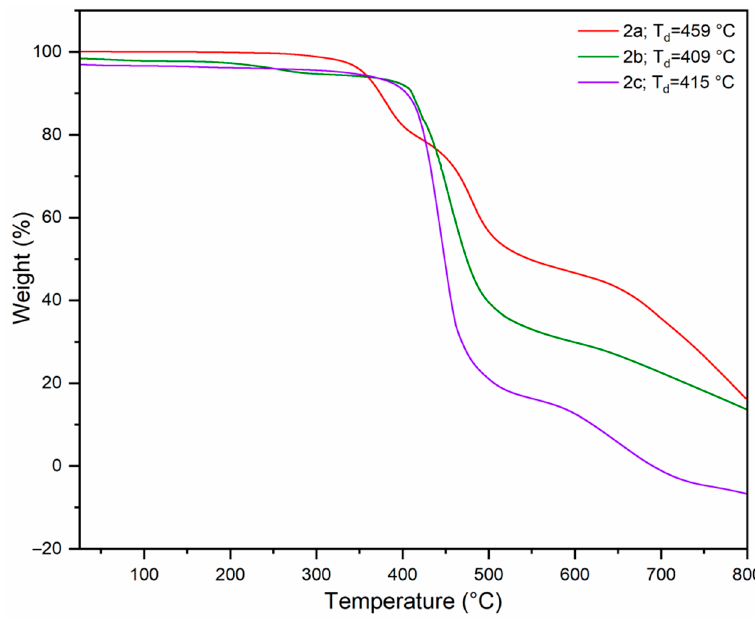
Figure 5. Thermal decomposition of the polymers bearing thiol moieties.